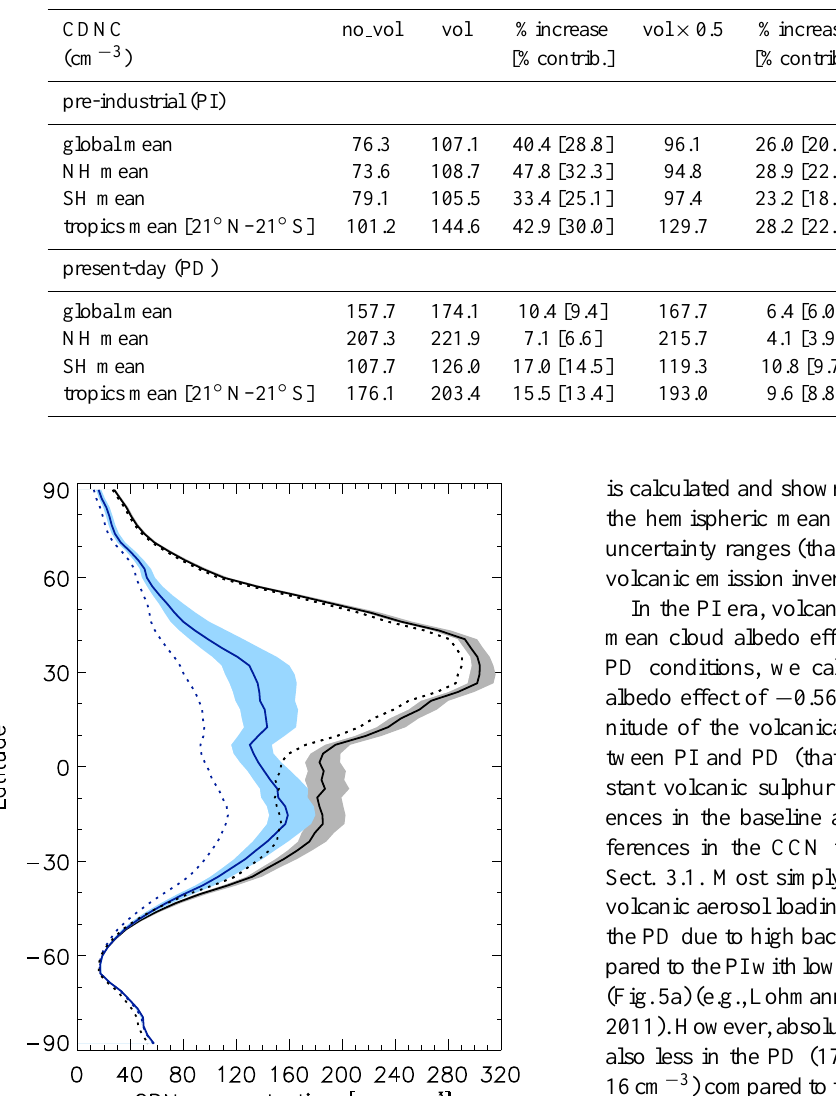
Table 3. Annual mean cloud droplet number concentrations (CDNC) at cloud-base altitude (approx. 970m above terrain or sea-level) for pre- industrial (PI) and present-day (PD). The relative increases and the relative contributions always refer to the run without volcanic emissions (i.e. no vol).